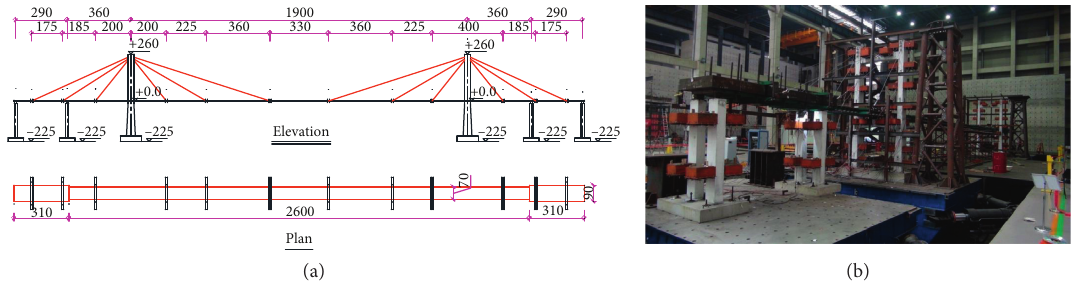
Figure 5: Bridge model. (a) Elevation and plan (unit: cm). (b) Reality image of bridge.